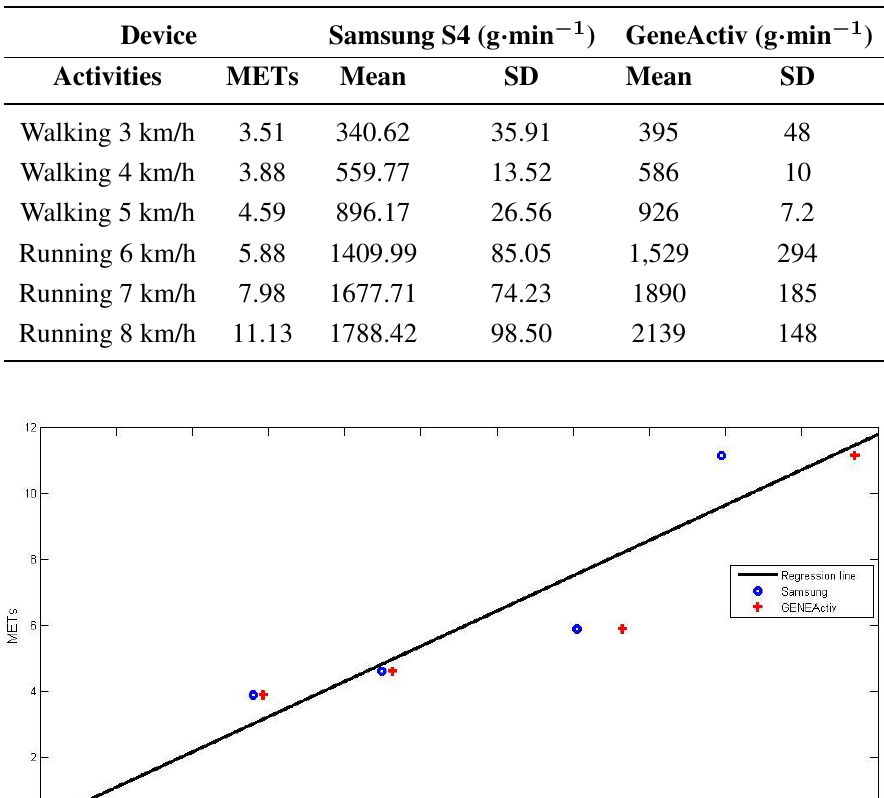
Table 5. Results from calibration. MET, metabolic equivalent task.